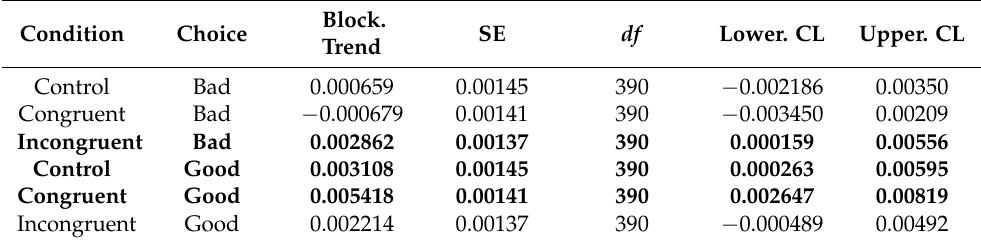
Table 5. Estimates and confidence intervals for the slopes of fixed effects of each Deck × Condition combination. A Kenward–Roger method has been used for degrees of freedom